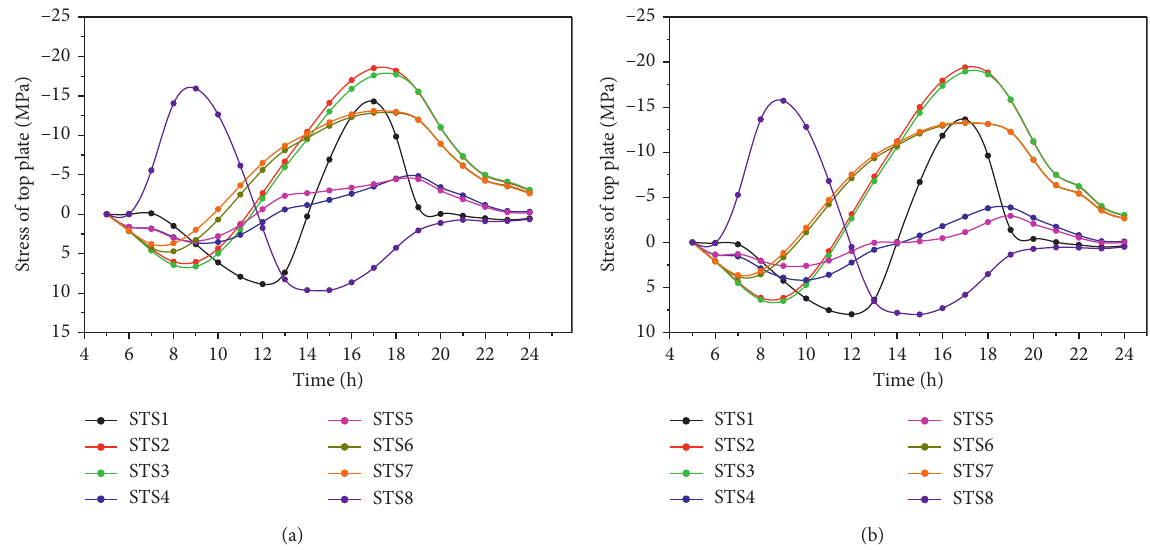
Figure 17: The stress variation of the top plate at segment S7 and segment M13. (a) The stress variation of the top plate at segment S7. (b) The stress variation of the top plate at segment